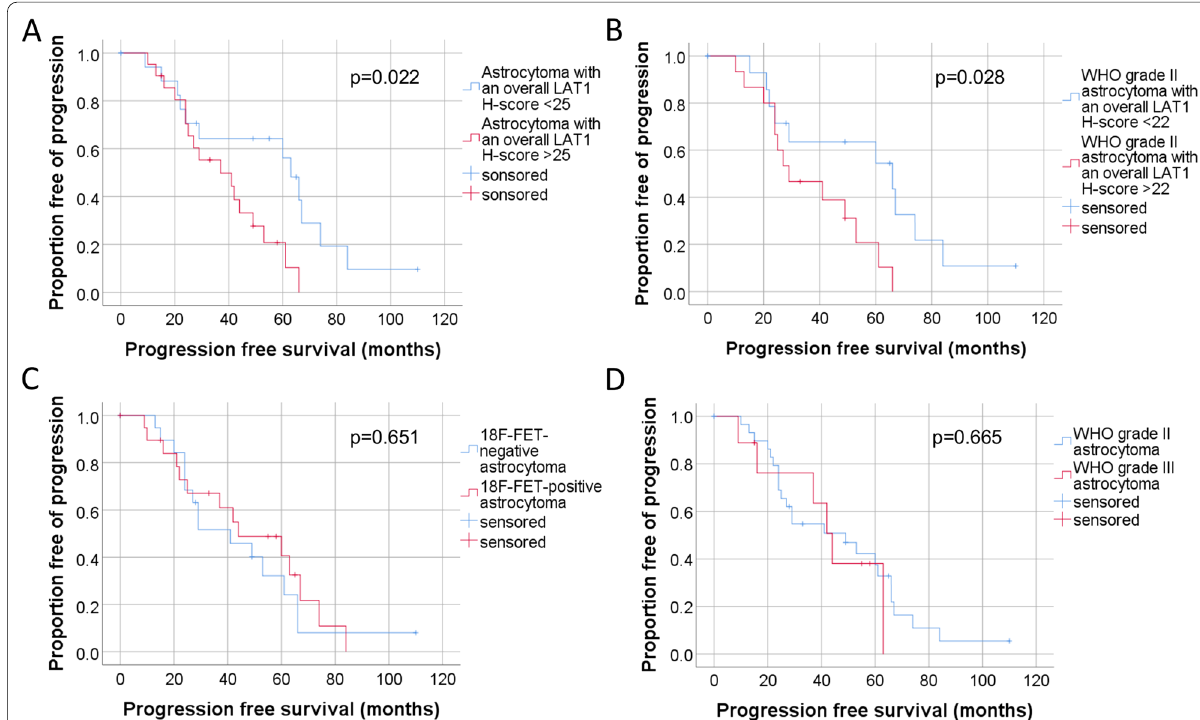
Fig. 4 Survival analysis of the LAT1 expression in the overall group ( A ), in WHO grade II astrocytomas ( B ), of 18 F‑FET‑positive versus 18 F‑FET‑negative astrocytomas ( C ) and of the WHO grade II and III astrocytomas ( D